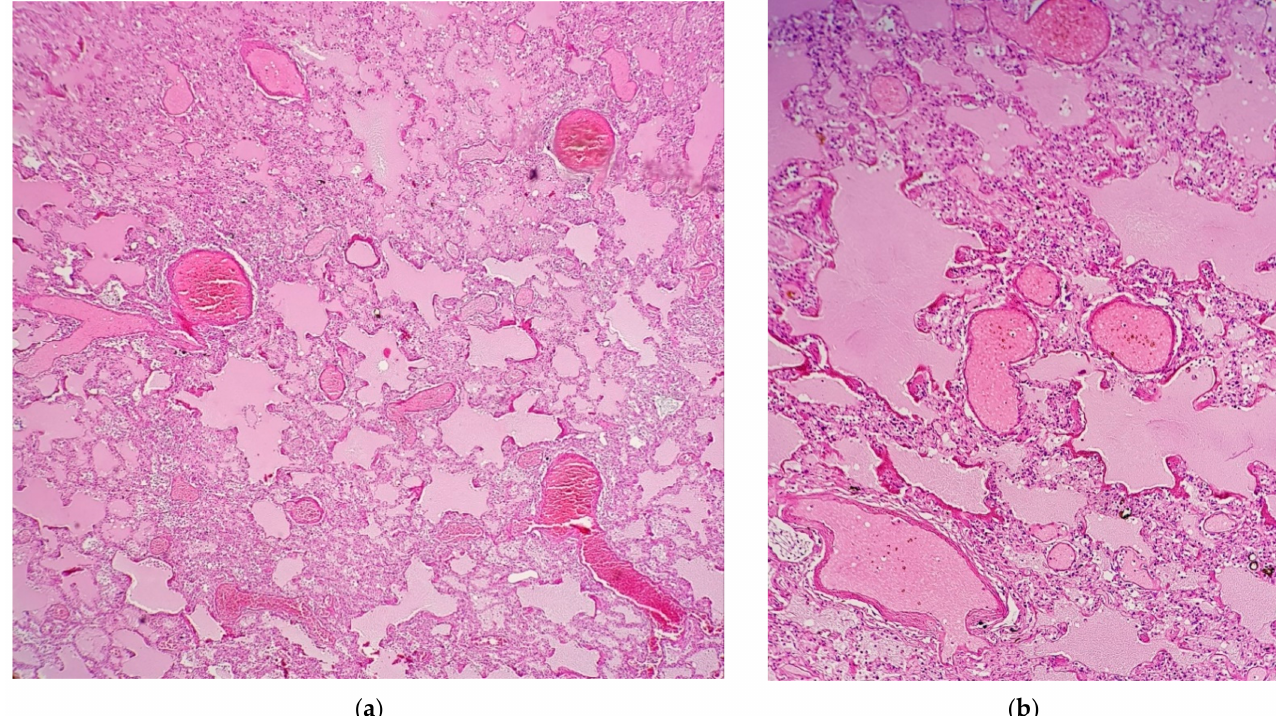
Figure 2. HE stain of maternal pulmonary tissue: ( a ) 100 × acute diffuse alveolar damage with massive alveolar edema, hemorrhage, severe vascular stasis, and vascular thrombosis; ( b ) 400 × —infiltration of lung tissue with inflammatory cells, especially in the alveolar septs, along with hyaline membrane formation and fibrin